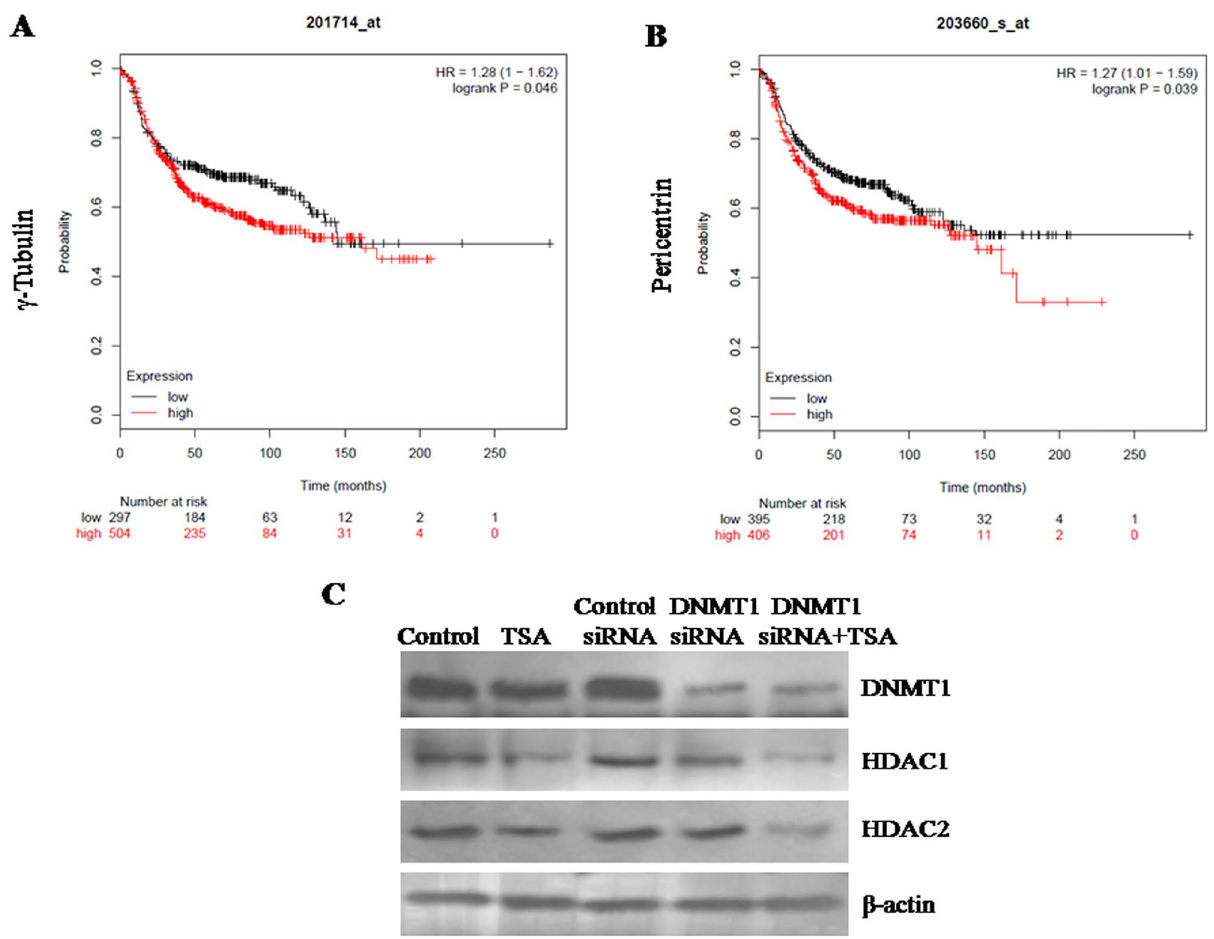
Figure 1. Overall survival analysis of patients using Kaplan–Meier survival plotter showing higher expression of ( A ) γ-tubulin ( p = 0.046, HR = 1.28) and ( B ) pericentrine ( p = 0.039, HR = 1.27) are associated with poor survival of breast cancer patients. Western blot analysis of the expression of DNMT1 as well as HDAC1 & HDAC2 showing ( C ) confirmation of the knock down of DNMT1 and inhibition of HDAC1 & HDAC2 after siRNA and TSA treatment respectively. The representative blots of replicates were presented here. The full-length original images (cropped) of representative blots were presented in the supplementary Fig. S2 of Supplementary information